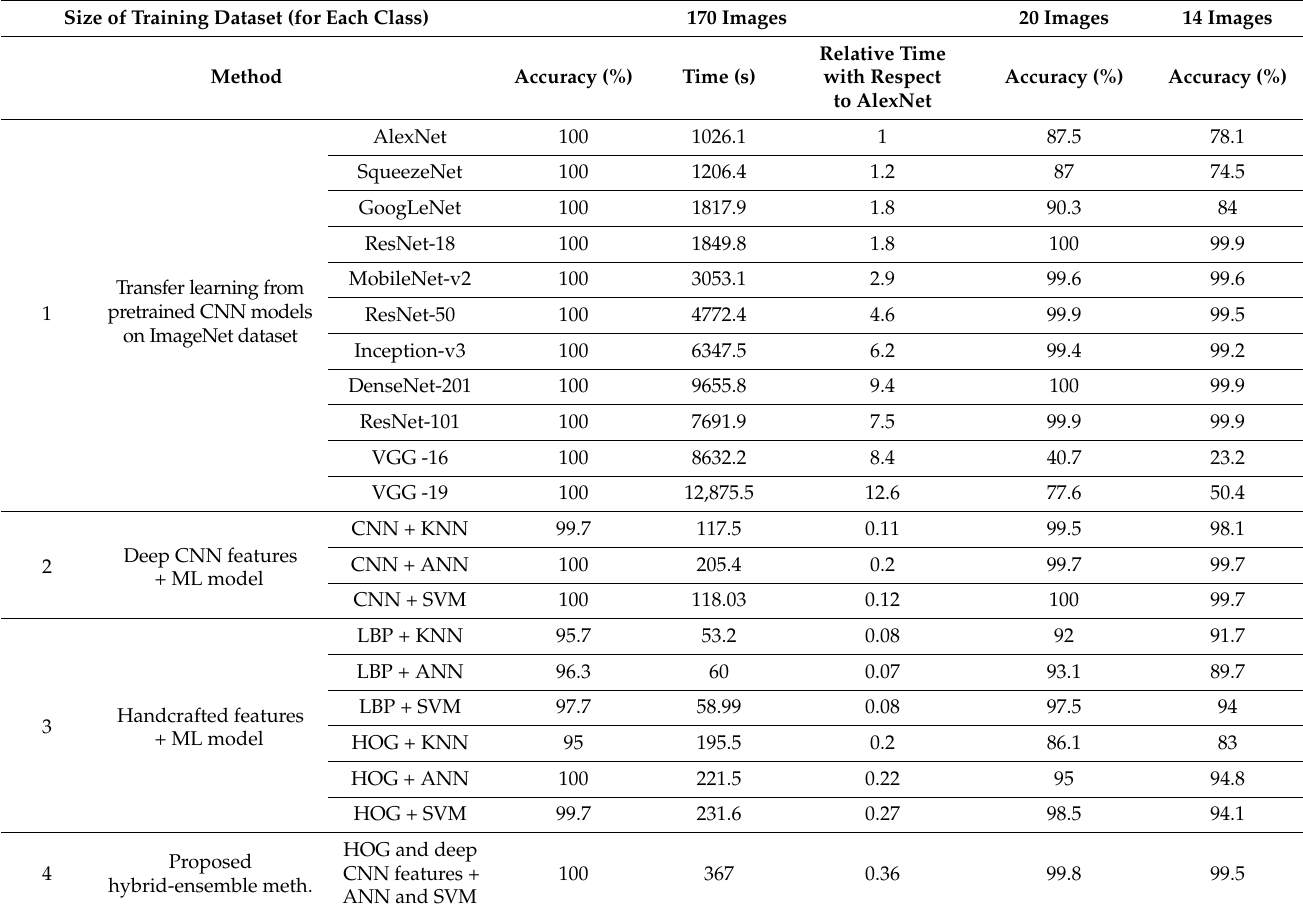
Table 4. Performance comparison results using different sizes of training datasets